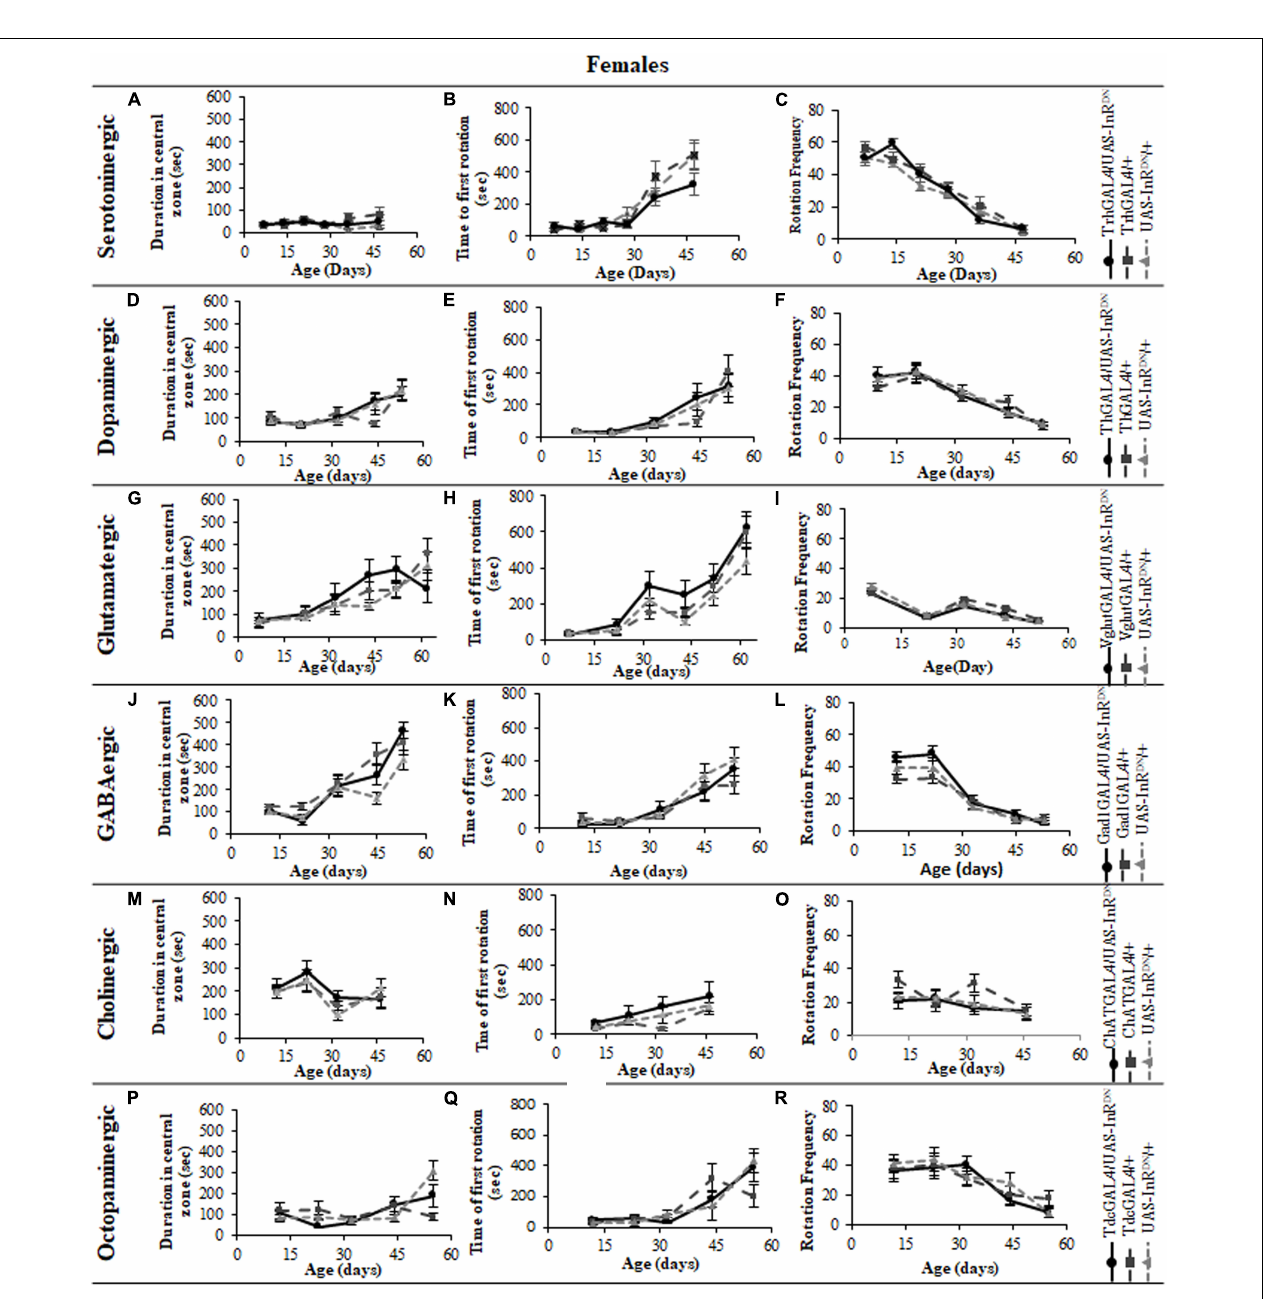
FIGURE 3 | The effect of neuronal subtype specific IIS reduction on locomotion during exploratory walking senescence in female flies. Exploratory walking senescence parameters for a cohort of once-mated female flies of the indicated genotypes run in parallel with the survival experiments shown in Figure 1 . Data